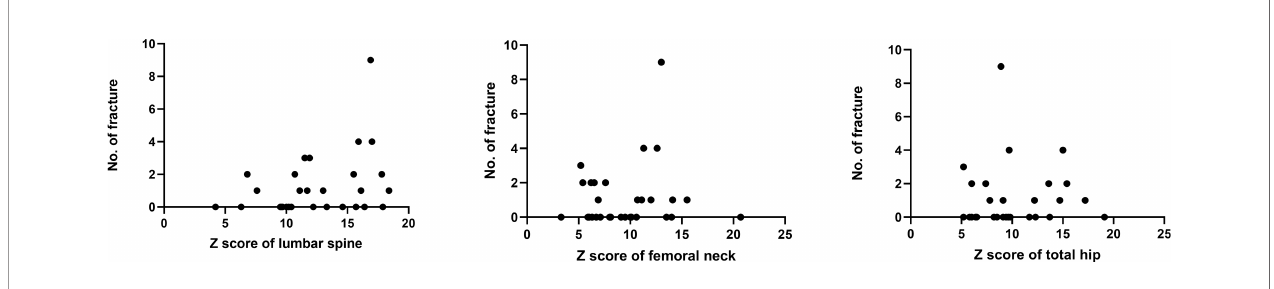
FIGURE 2 | Relationship between BMD Z scores and